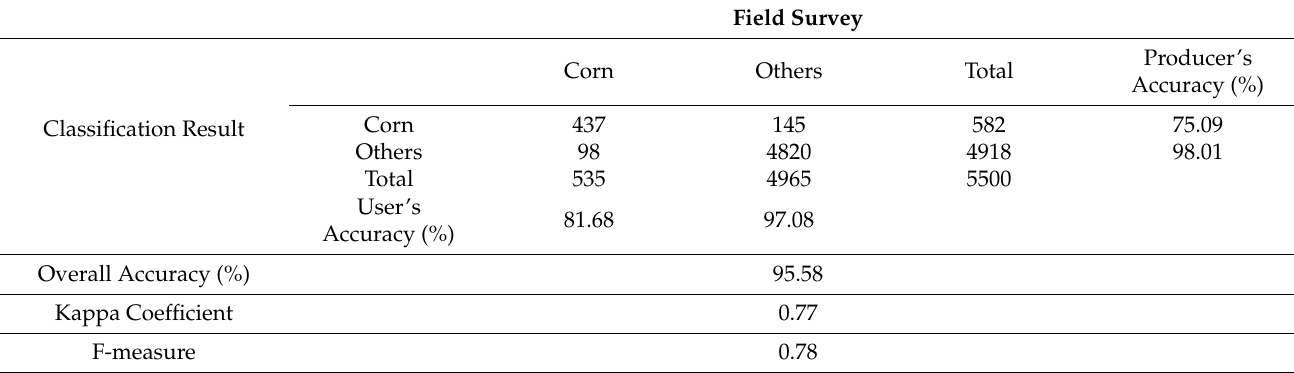
Table 5. Error matrix for evaluating the accuracy of the Farm Map-based SVM algorithm.